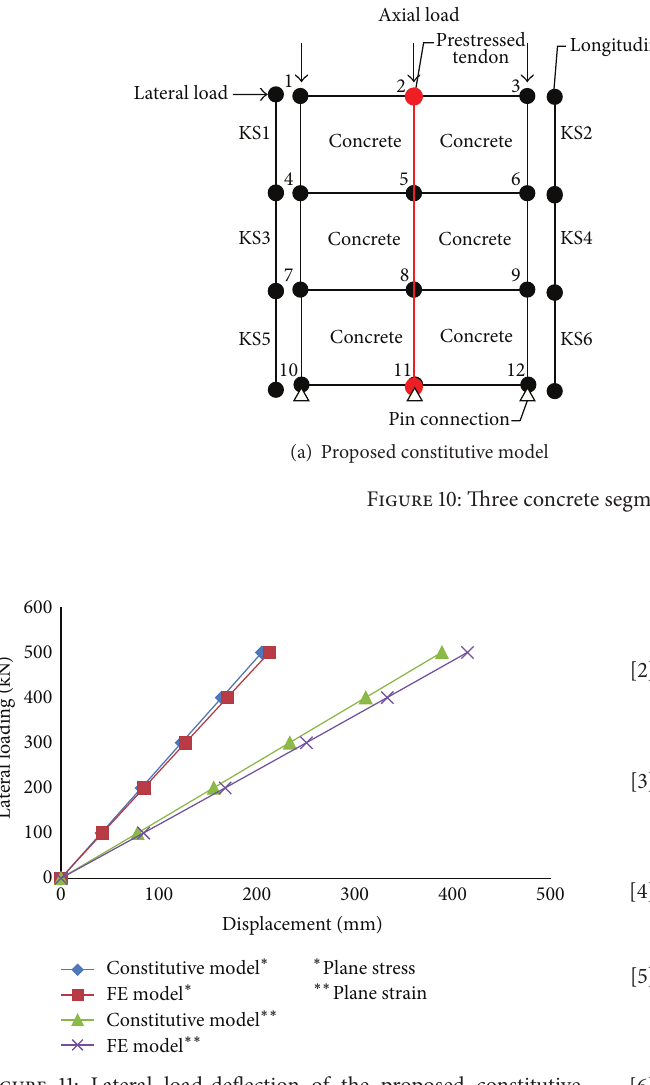
Figure 11: Lateral load-deflection of the proposed constitutive model and FE model for